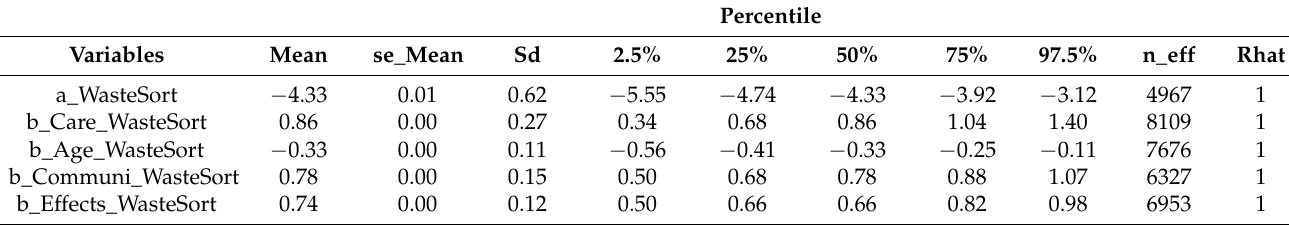
Table 3. Estimated results of waste sorting